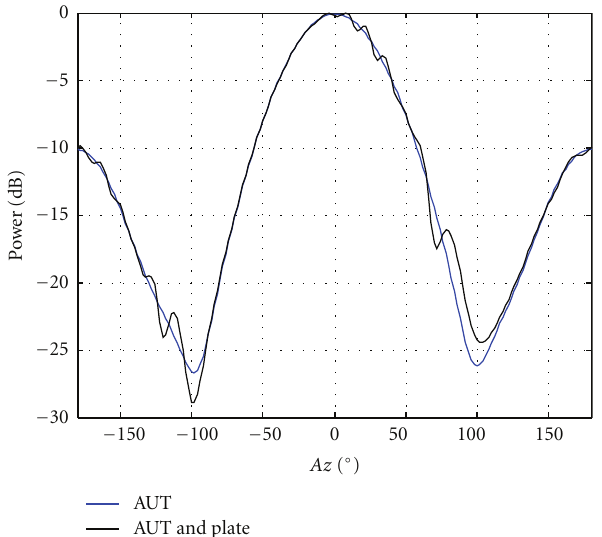
Figure 3: Far-field phase pattern of OEWG with and without plate. AUT o ff set = 10cm.